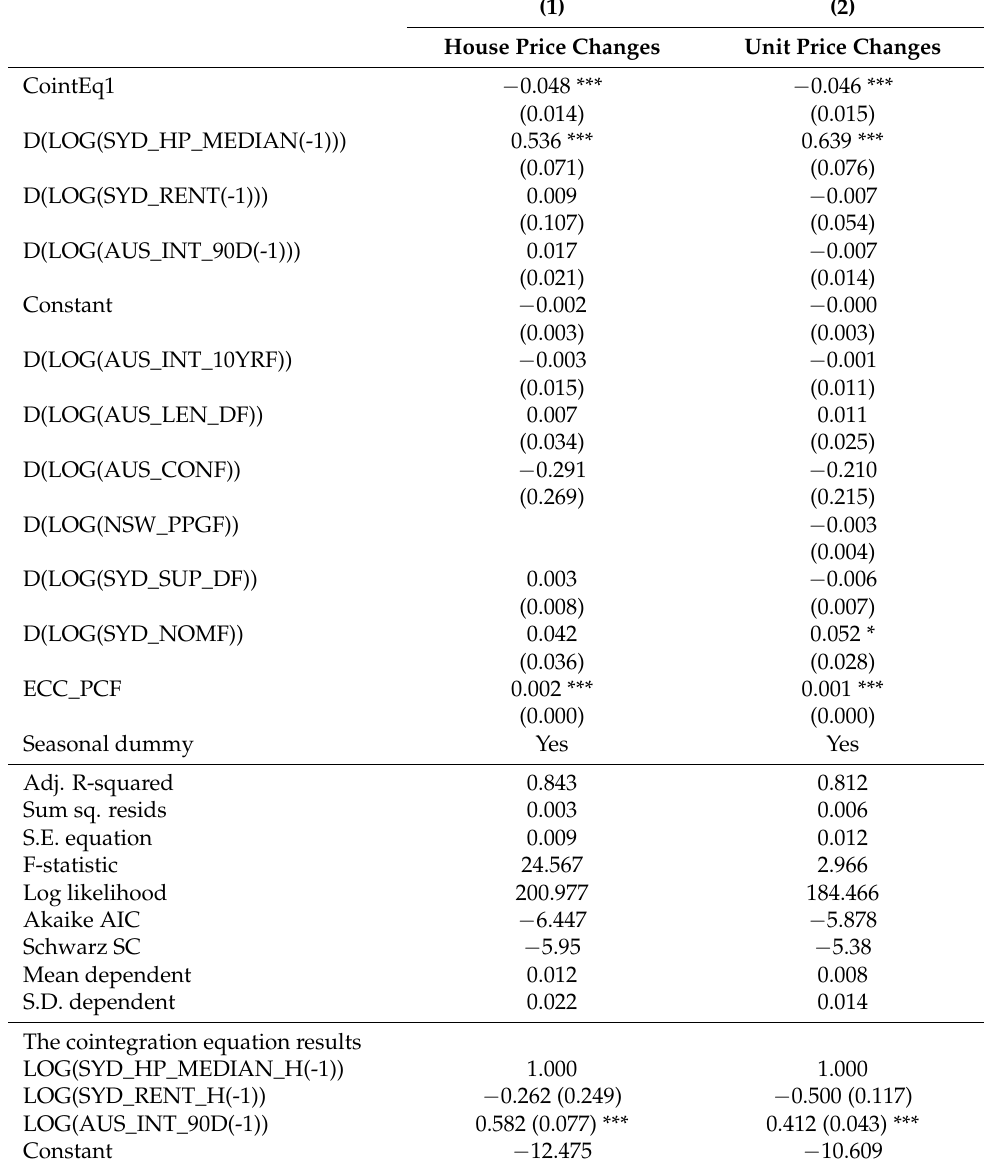
Table 2. Model development—Error correction model estimates, Q3 2004–Q4